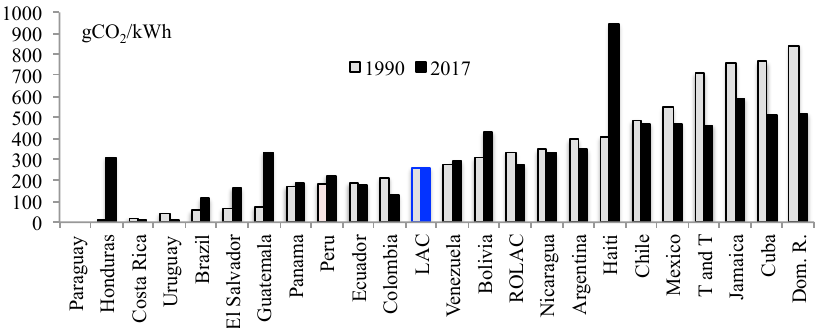
Figure 2. The aggregate carbon intensity by LAC country, 1990–2017.